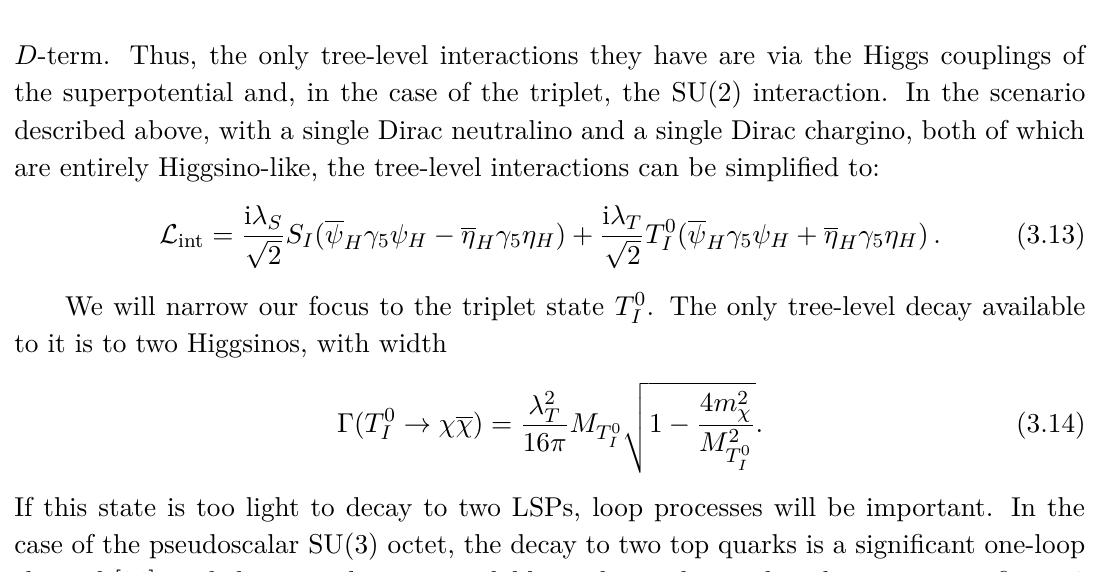
Figure 3 . The one-loop decays of the neutral pseudoscalar